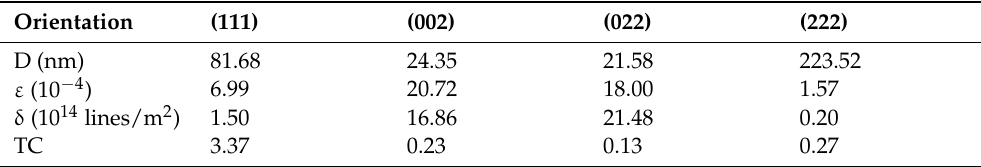
Table 2. Values of crystallite size D, dislocation density ε , micro-strain δ and texture coefficient TC of NiO films.